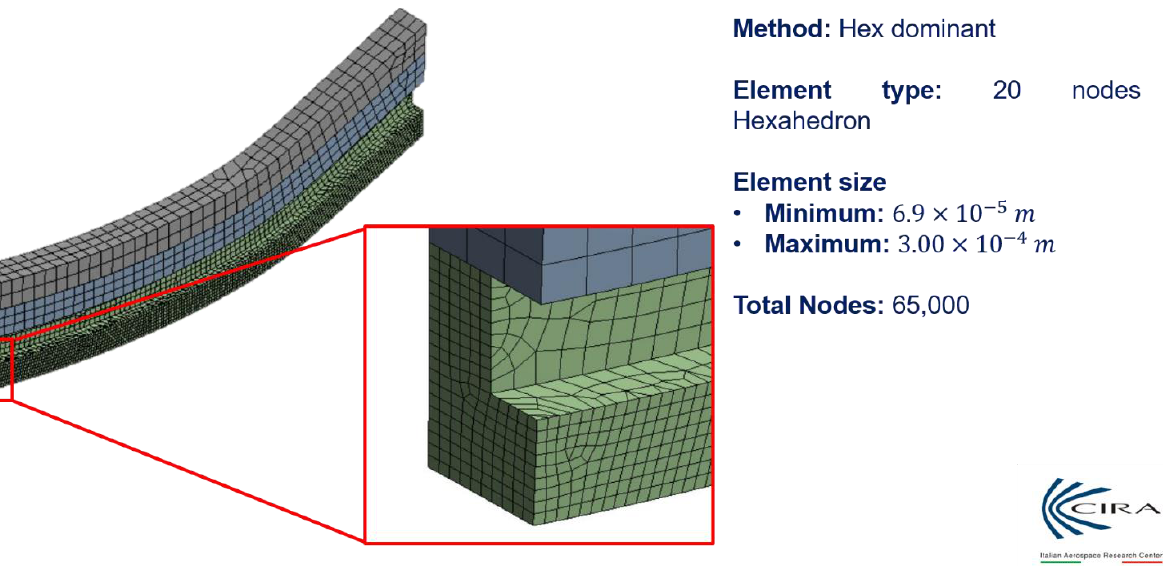
Table 9. Load and time steps considered in the numerical analyses. Load Steps [-]